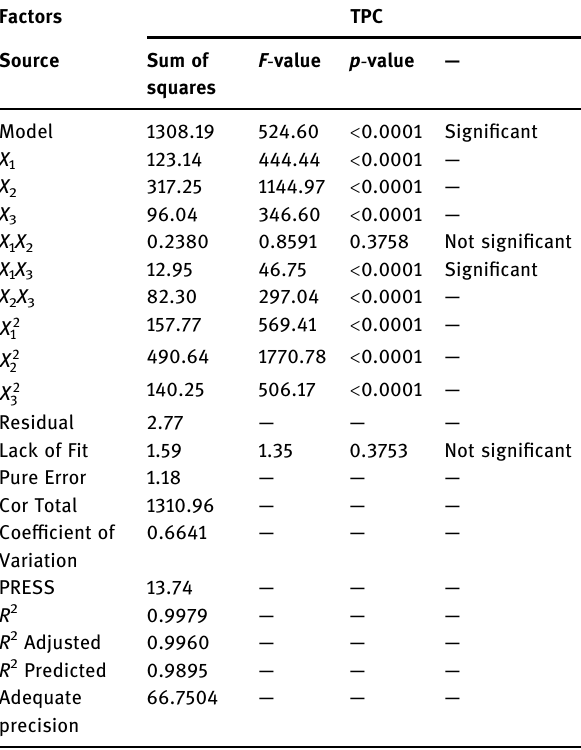
Table 3: Analysis of Variance ( ANOVA ) results for the quadratic model for